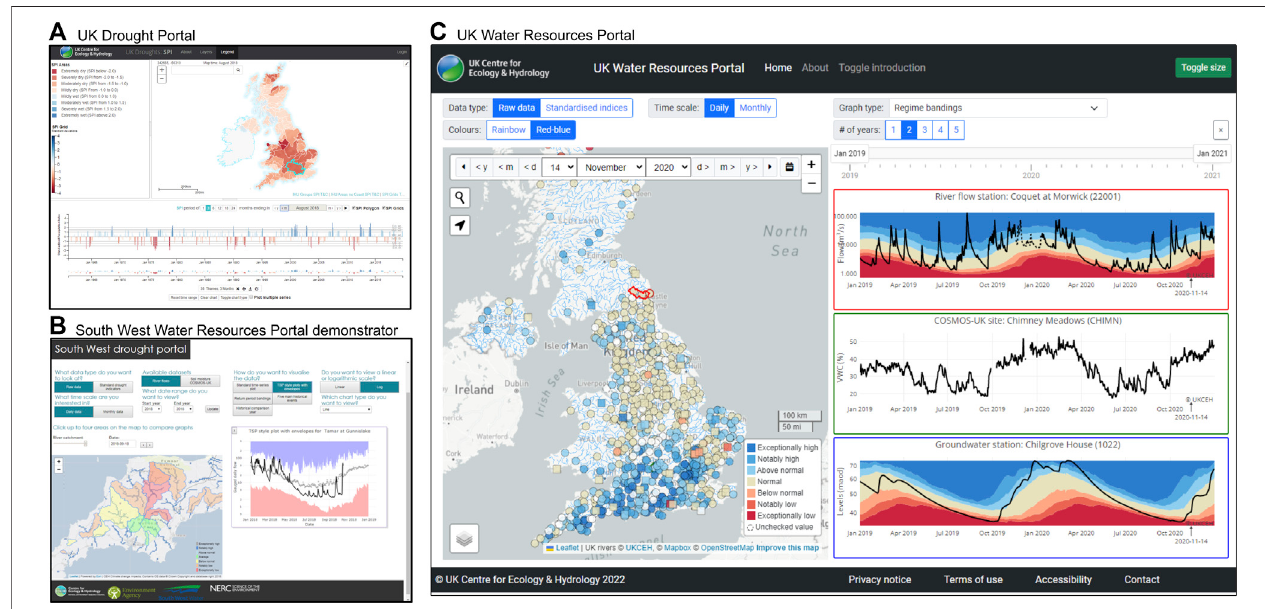
FIGURE 1 | EvolutionoftheUKWaterResourcesPortal: (A) screenshotoftheUKDroughtPortalshowingtheSPI-3fortheUK, (B) screenshortoftheSouthWestWater ResourcesDemonstratorPortalshowingriver fl owdatafromthesouthwestofEngland; (C) screenshotoftheUKWaterResourcesPortalshowingmapandtimeseriesdatafor the 14 November 2020 for river fl ows, soil moisture and groundwater levels at sites across England showing the default graph types in the red-blue colour